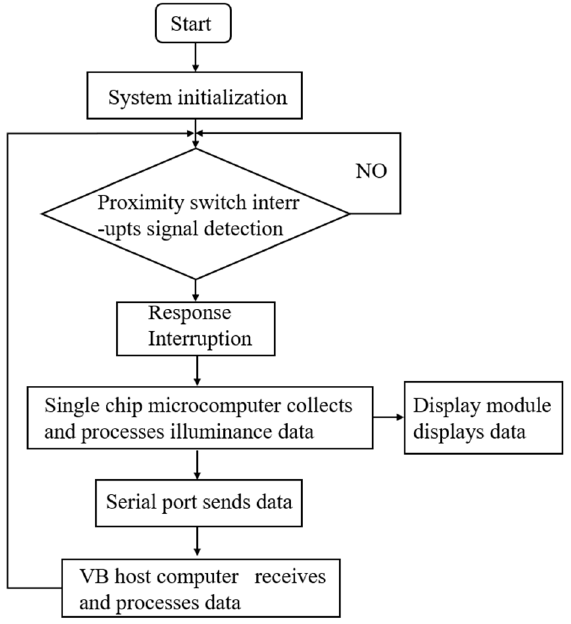
Figure 7. Single-chip microcomputer program flow chart.